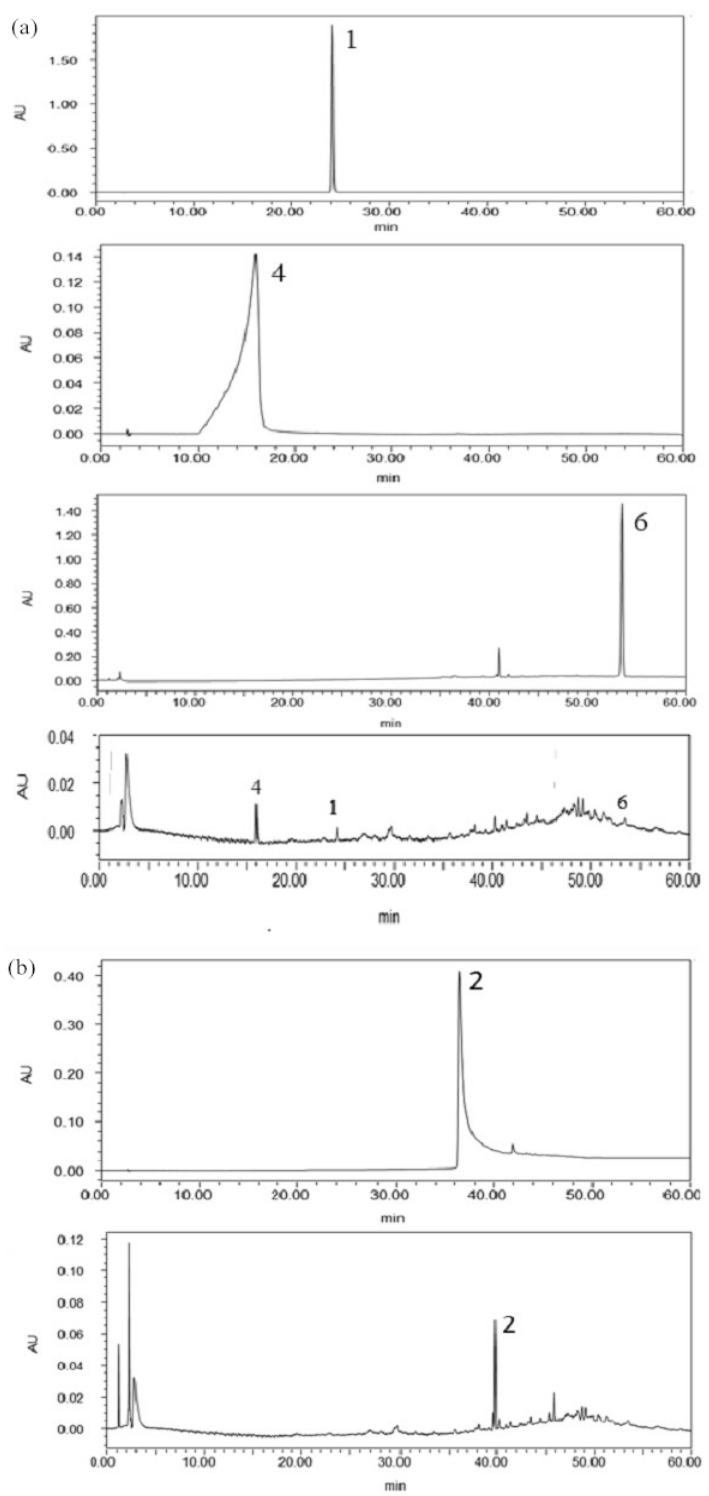
Figure 6. HPLC analysis of the allelochemicals in the rhizosphere soil of continuously cropped potato at 240 nm ( a ) and 320 nm ( b ), respectively; purified compounds 1 , 4 , and 6 were detected at 240 nm ( a ) and compound 2 was detected at 320 nm ( b ).